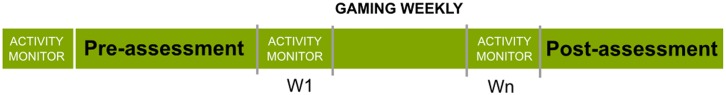
Clinical study assessments.